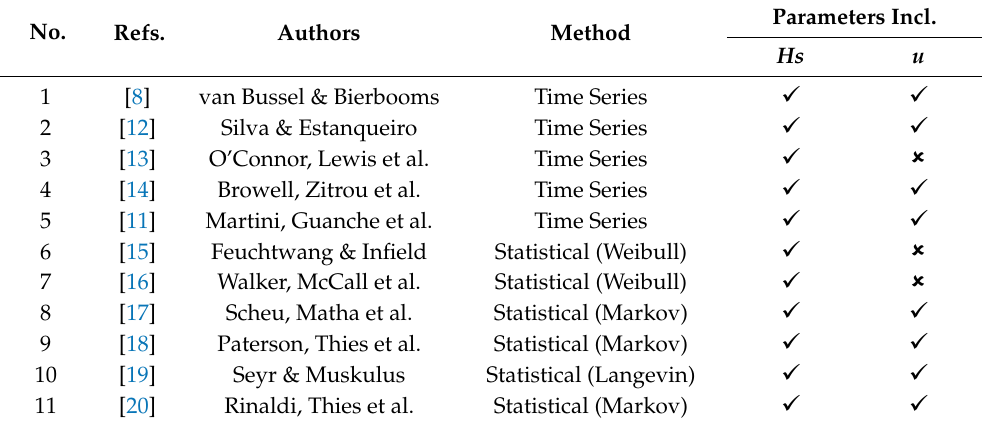
Table 1. Summary of accessibility studies .